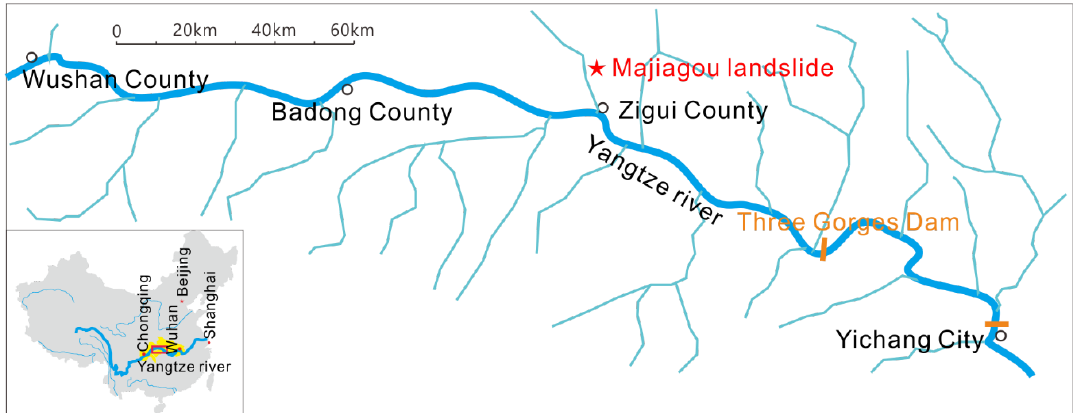
Figure 11. Majiagou landslide test site location.